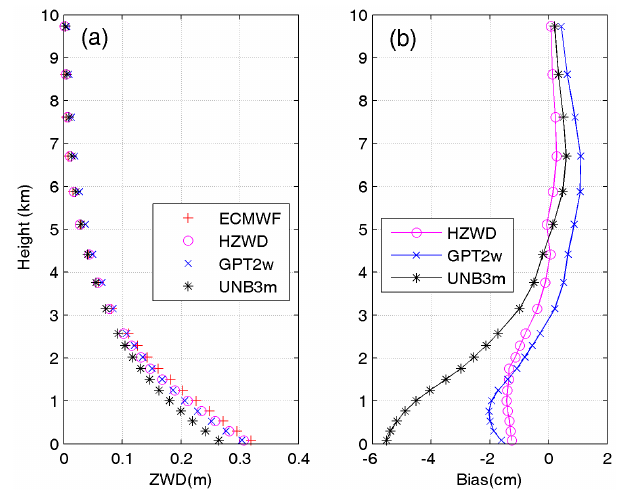
Figure 7. The ZWD profiles (a) of ECMWF and the three models (HZWD, GPT2w, and UNB3m) and corresponding biases (b) at a grid point (0 ◦ N, 20 ◦ E) at 12:00UTC on 1 January 2015.